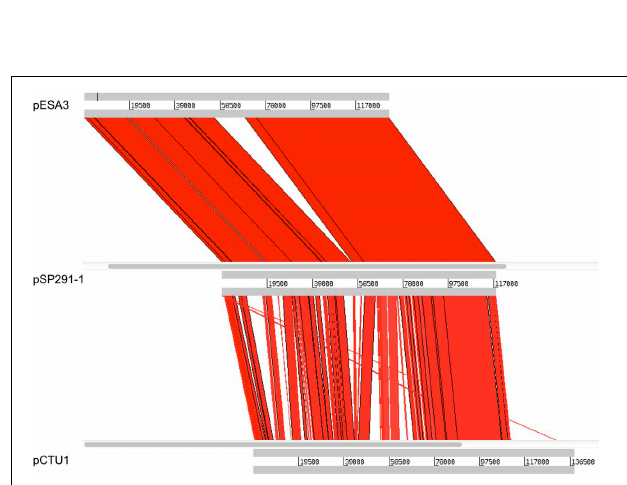
FIGURE A2 | Comparision of plasmid group 1 (pESA3, pSP291-1, and pCTU1) using Artemis comparison tool (ACT).